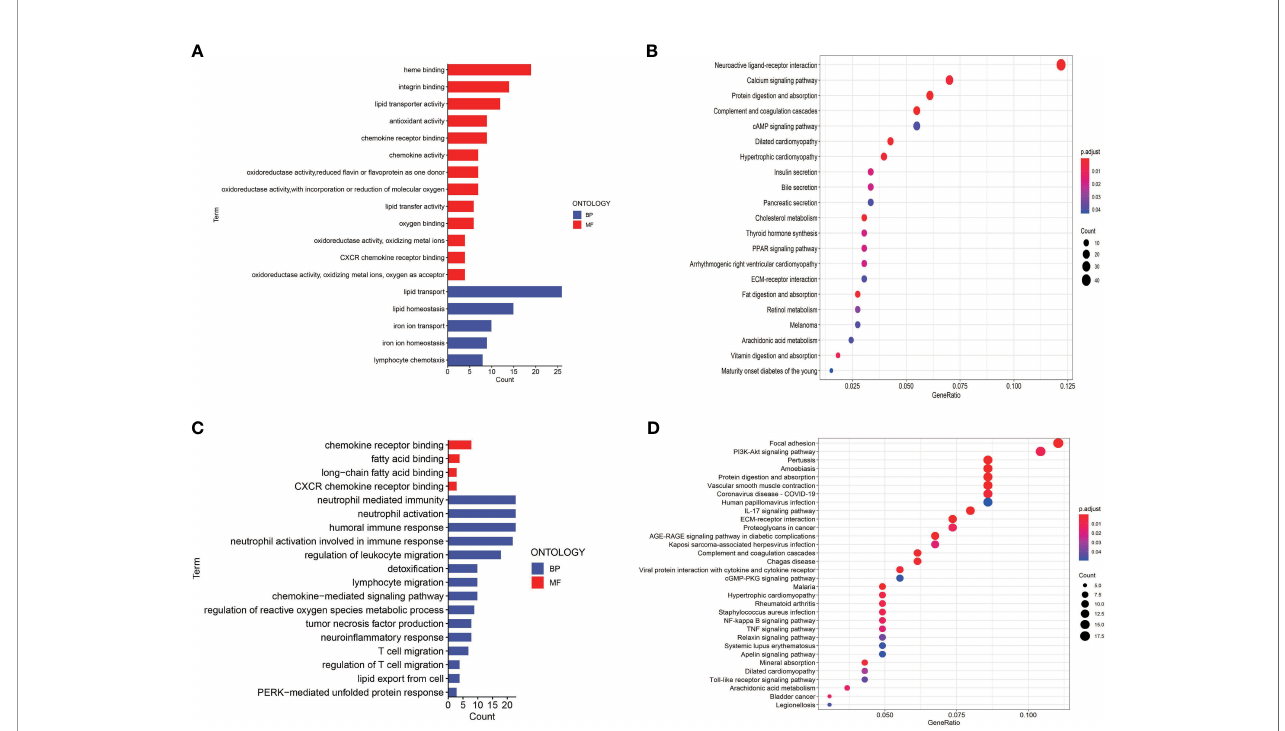
FIGURE 8 | Gene Ontology (GO) and Kyoto Encyclopedia of Genes and Genomes (KEGG) enrichment analysis in TCGA and GEO cohorts. (A) GO enrichment analysis in the TCGA cohort. (B) KEGG enrichment analysis in the TCGA cohort. (C) GO enrichment analysis in the GEO cohort. (D) KEGG enrichment analysis in the GEO